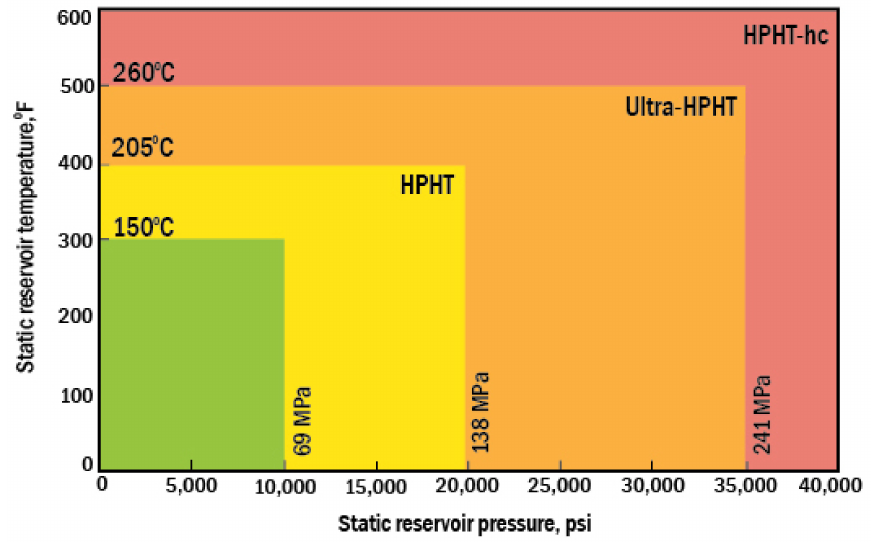
Figure 1. HPHT classification by Schlumberger